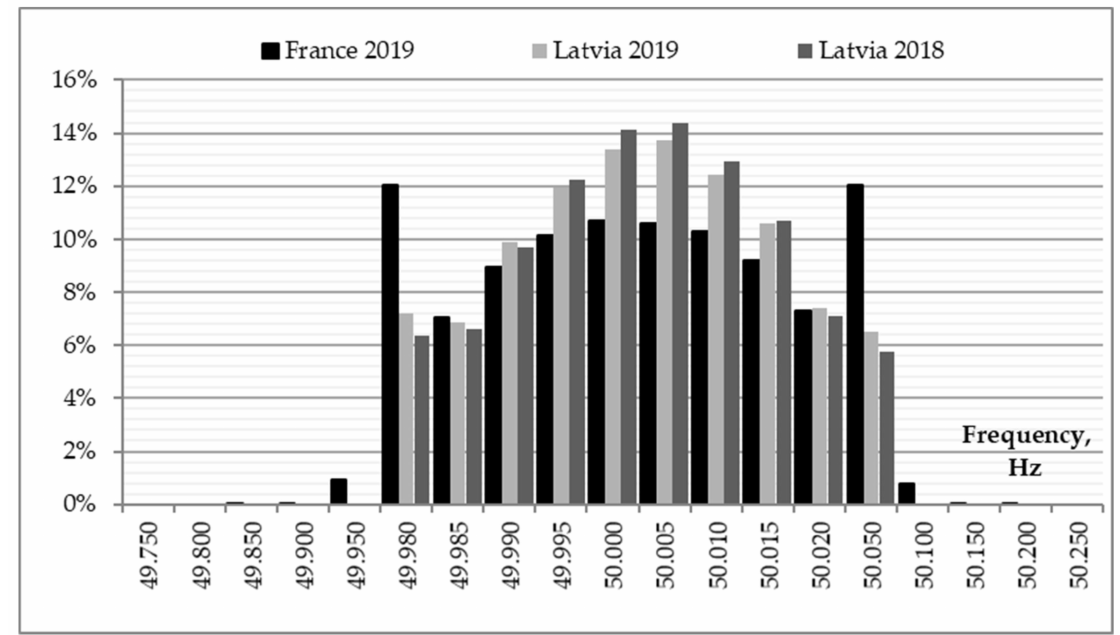
Figure 5. Frequency histogram of Latvian and French power